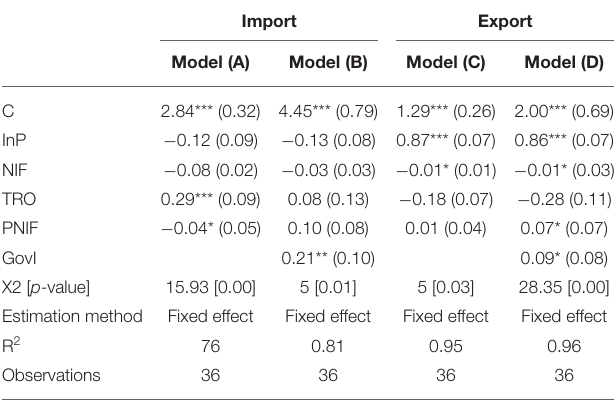
TABLE 5 | Estimated results of the north-east